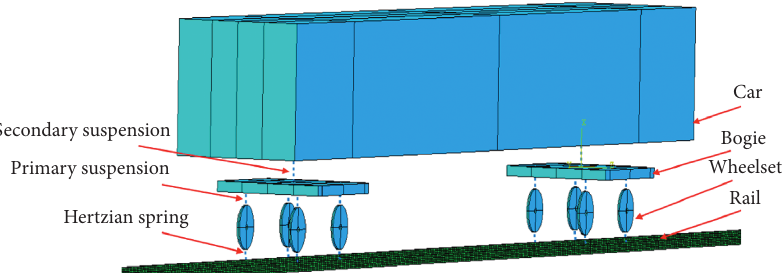
Figure 2: Representative view of the train model together with bogie and wheelset design.